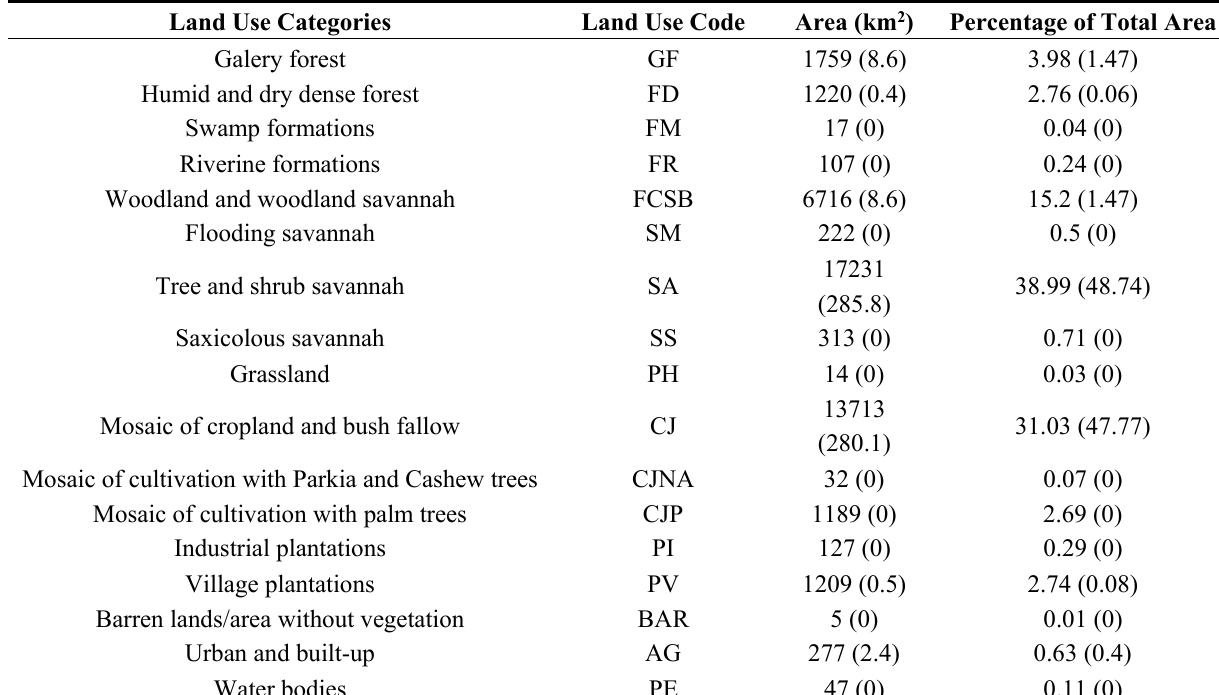
Table 6. Land use/cover categories, their area and percentage of total area for the Ouémé-Bonou catchment (49,256 km 2 ). Values displayed in brackets are related to the Donga-Pont catchment (586 km²) [64]. SWAT model was adapted to consider almost all land use classes mentioned in the table.